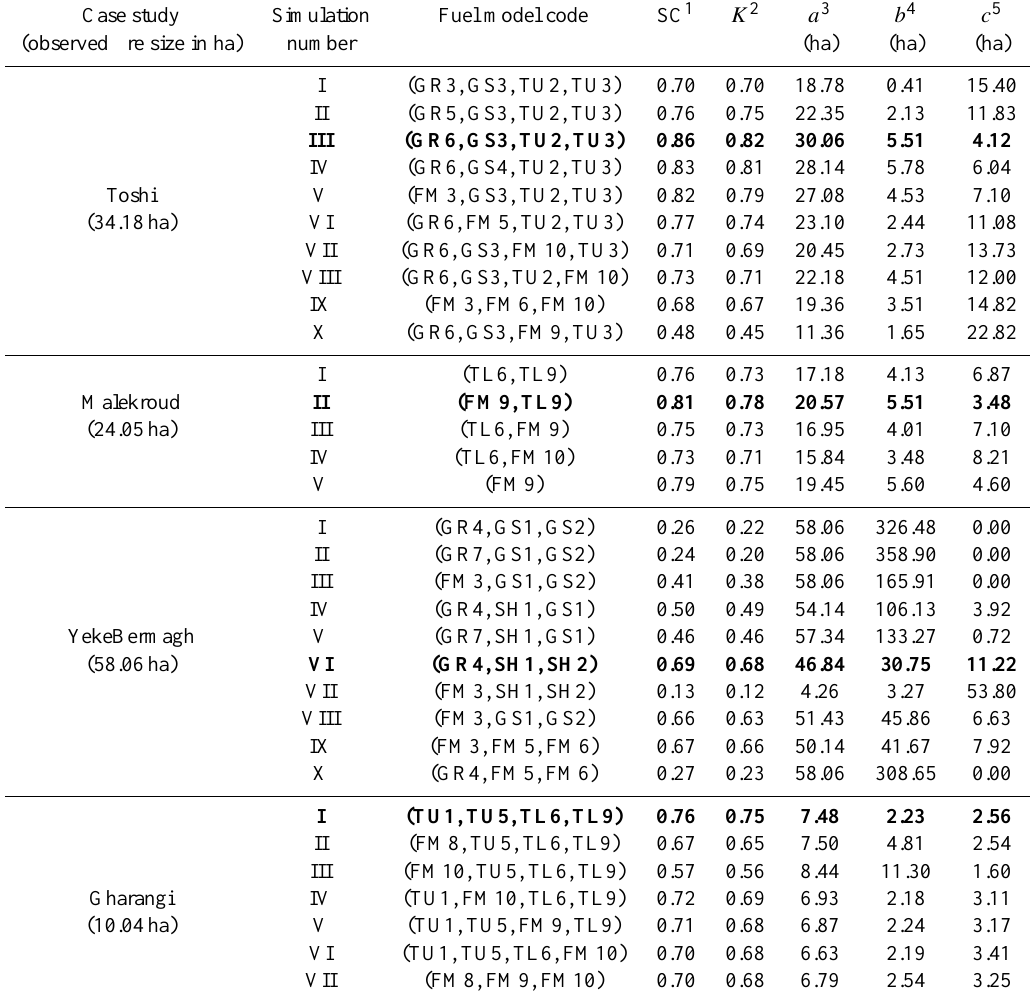
Table 4. Statistical evaluation of FARSITE performances for different combinations of standard fuel models. Case study (observed fire size in